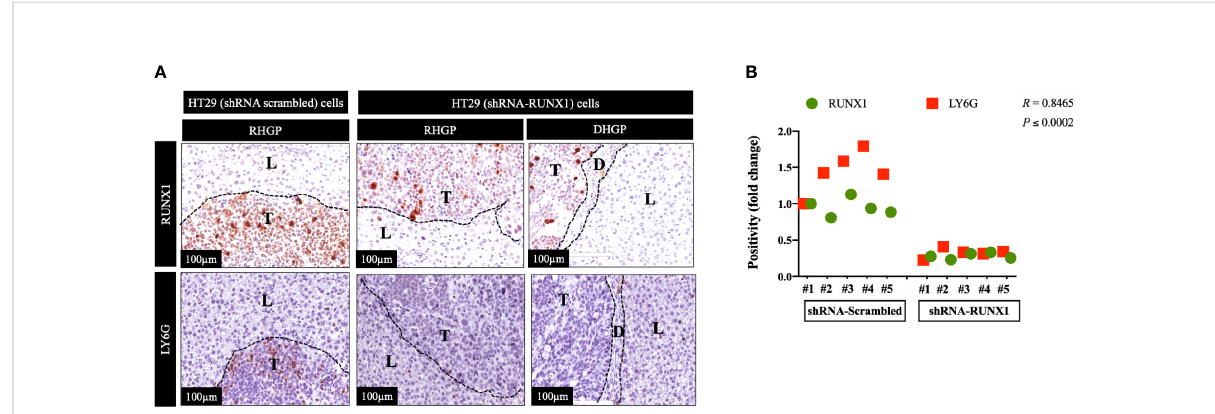
FIGURE 1 RUNX1 knockdown in the cancer cells attenuates neutrophil in fi ltration. (A) Represents immunohistochemical staining of CRCLM sections generated from HT29 cancer cells expressing shRNA-Scrambled (n=5) or shRNA-RUNX1 (n=5). We used anti-RUNX1 and anti-LY6G